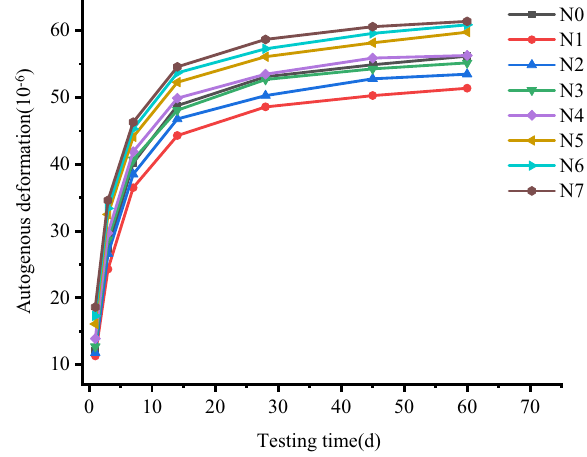
Figure 9: Shrinkage rate of